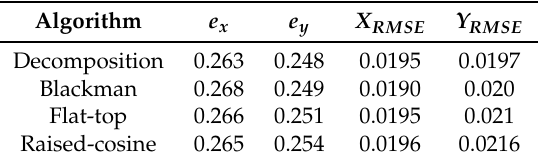
Table 1. The comparison of performance for different methods of eliminating the effect of image border in the case of estimating the